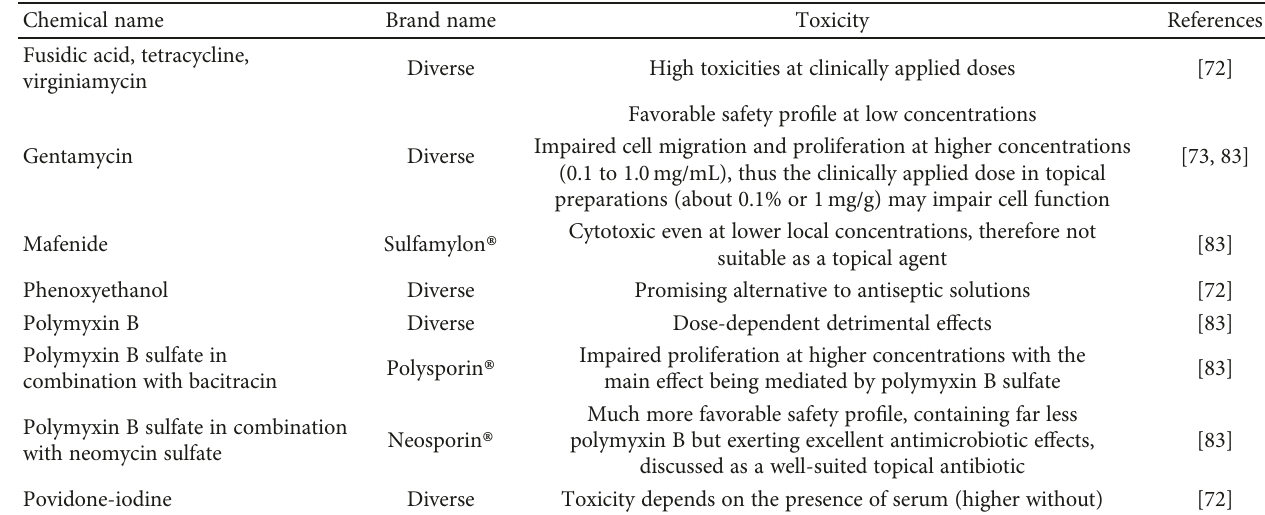
Table 2: Experiences with drug interactions on skin